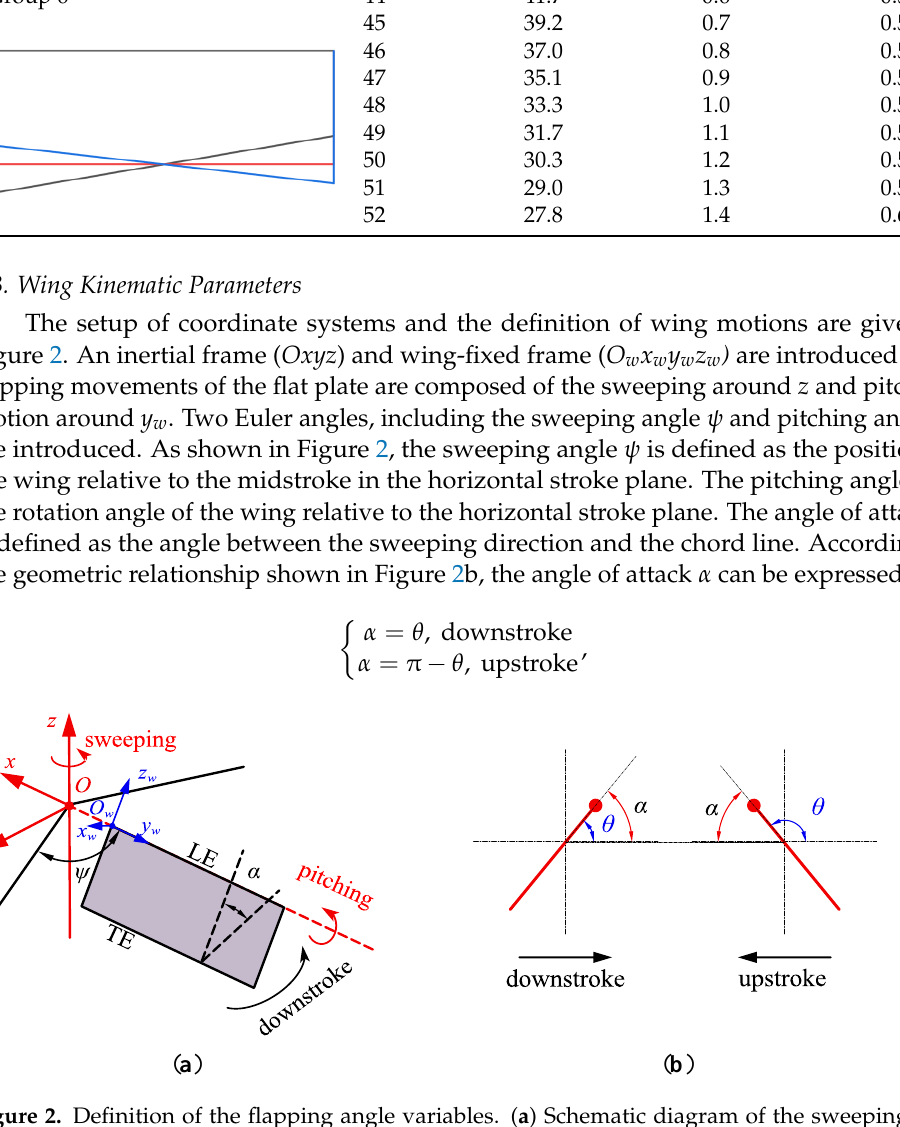
Table 3. Wings with different r 2 by changing the taper ratio λ .